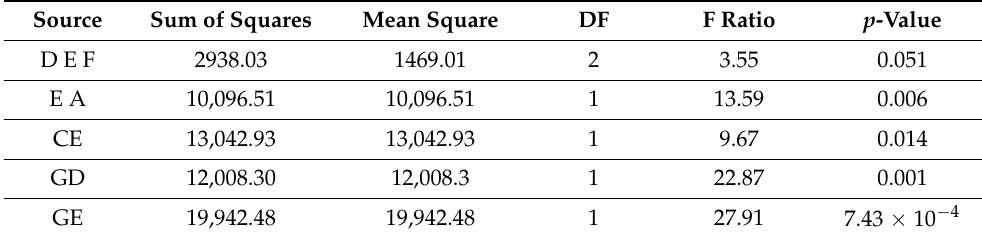
Table 4. ANOVA results on coating thickness of ultrasonic bonding experiments.